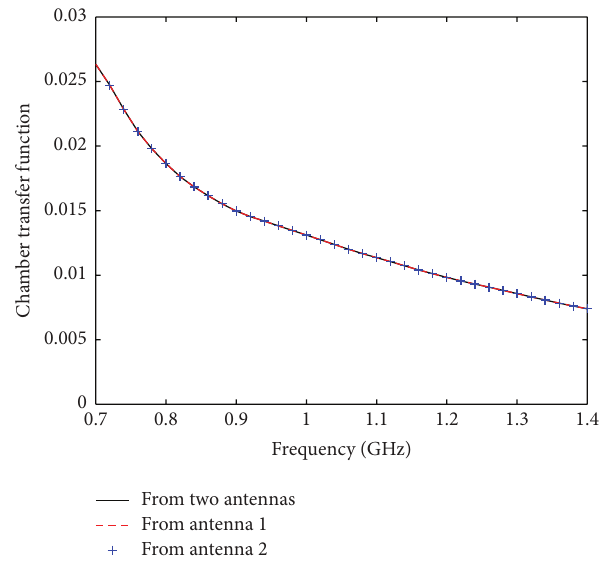
Figure 10: Measured chamber transfer